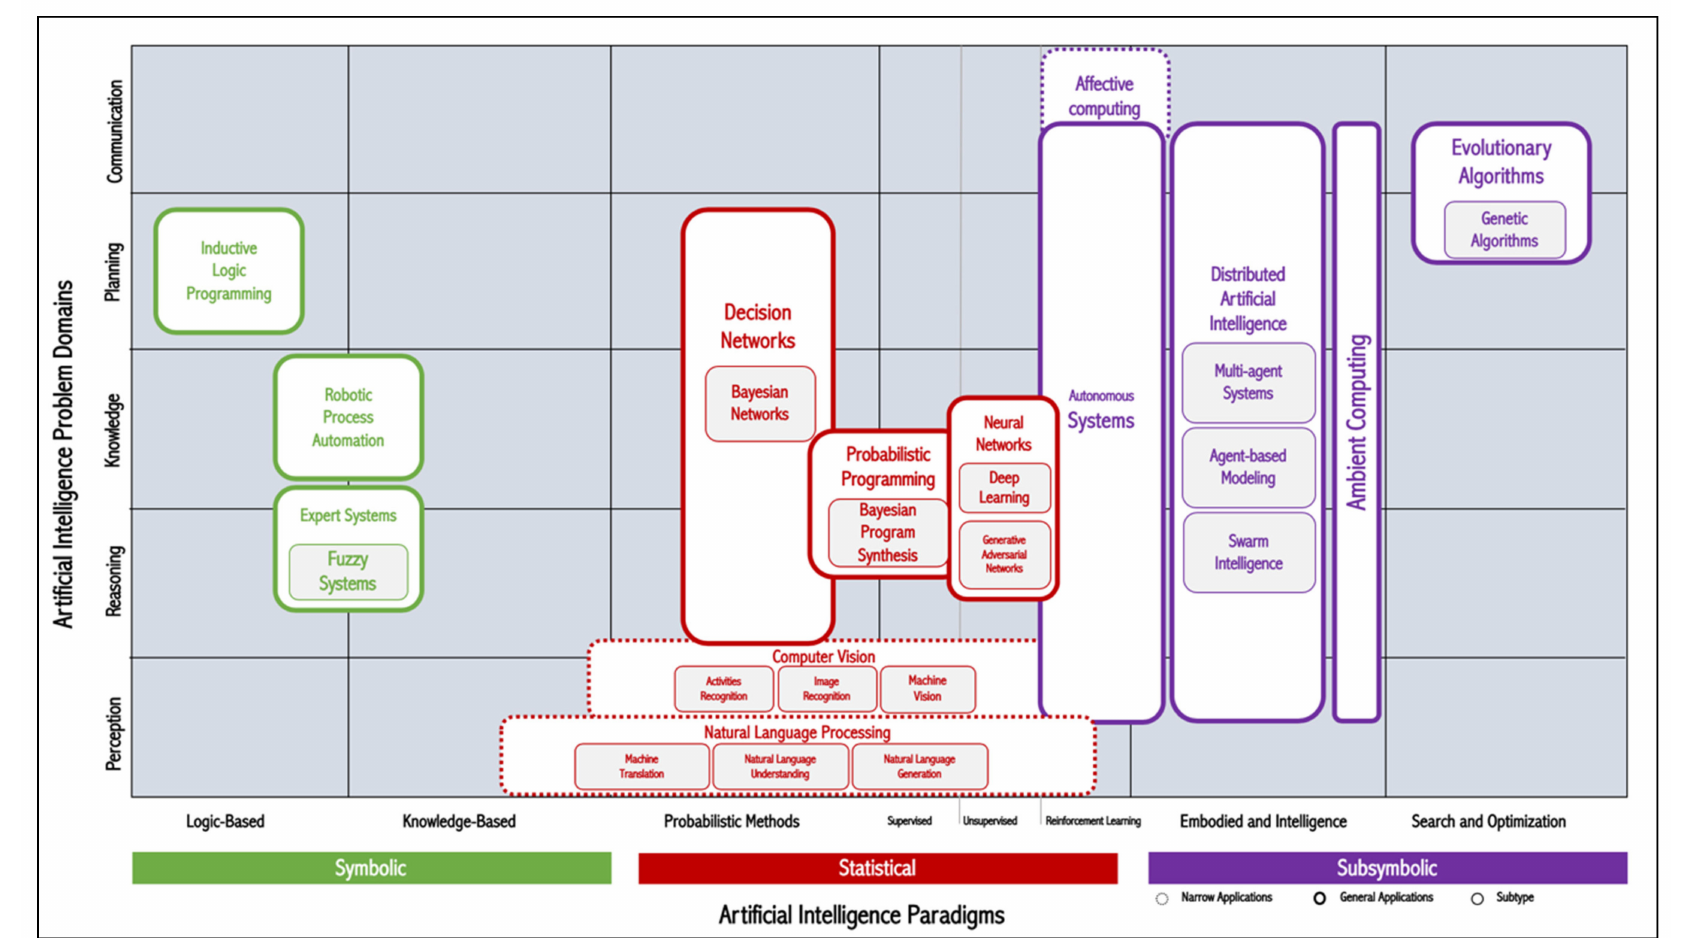
Figure 1. Classification of AI-driven computational techniques, derived from Corea